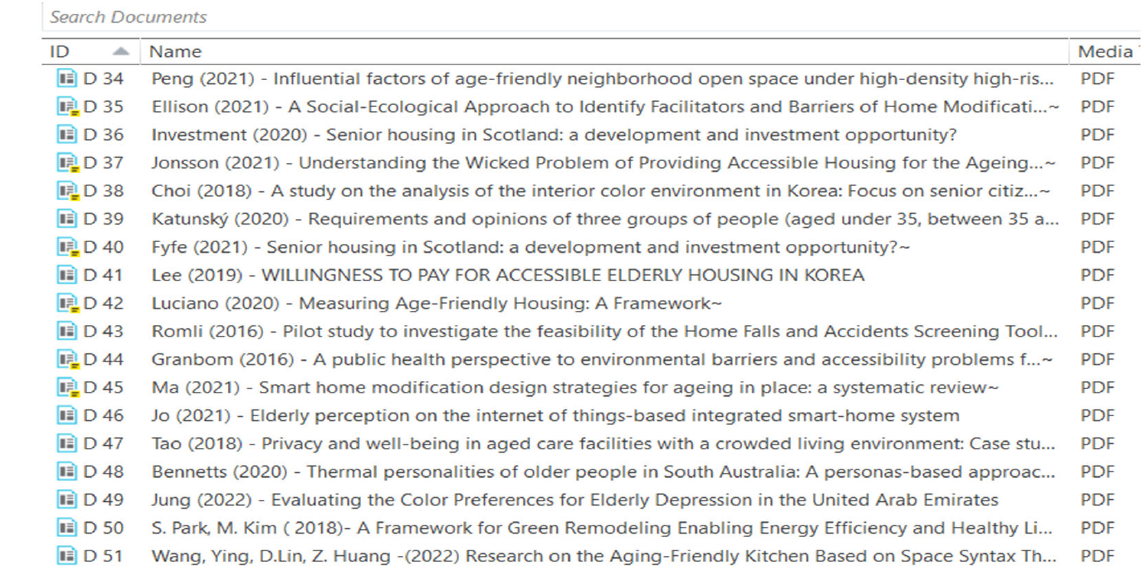
Figure 2. Documents established from Mendeley metadata.